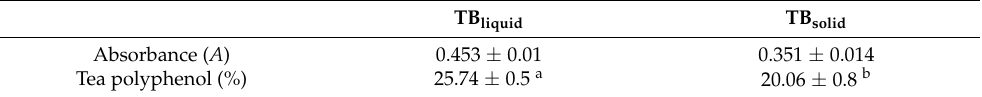
Table 7. The content of total phenols in theabrownins obtained from solid-state fermentation and liquid-state